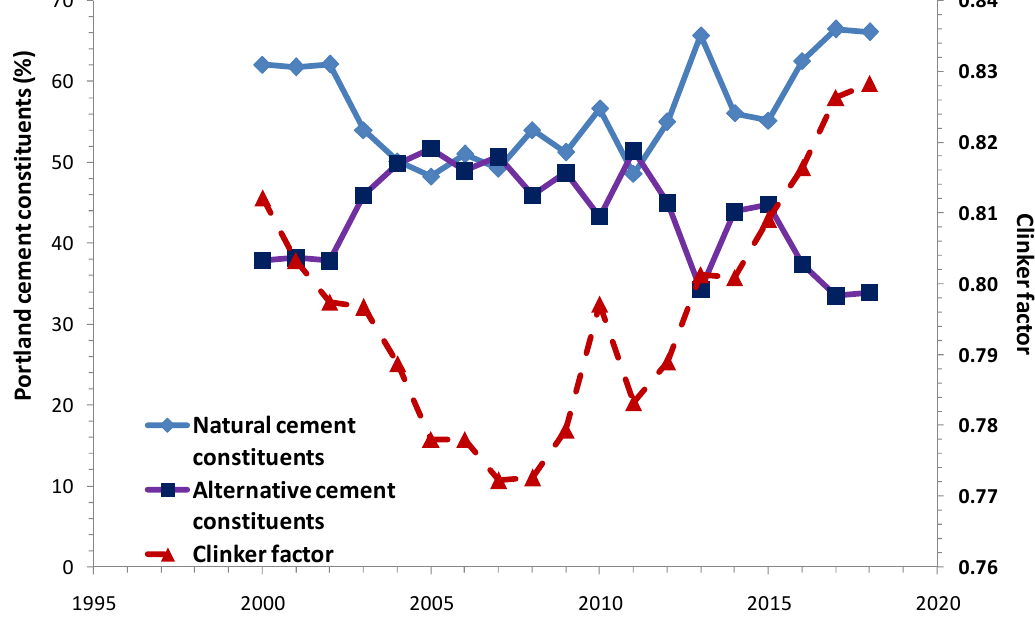
Figure 7. Clinker factor and alternative cement constituents in Spain from 2000 to 2018.